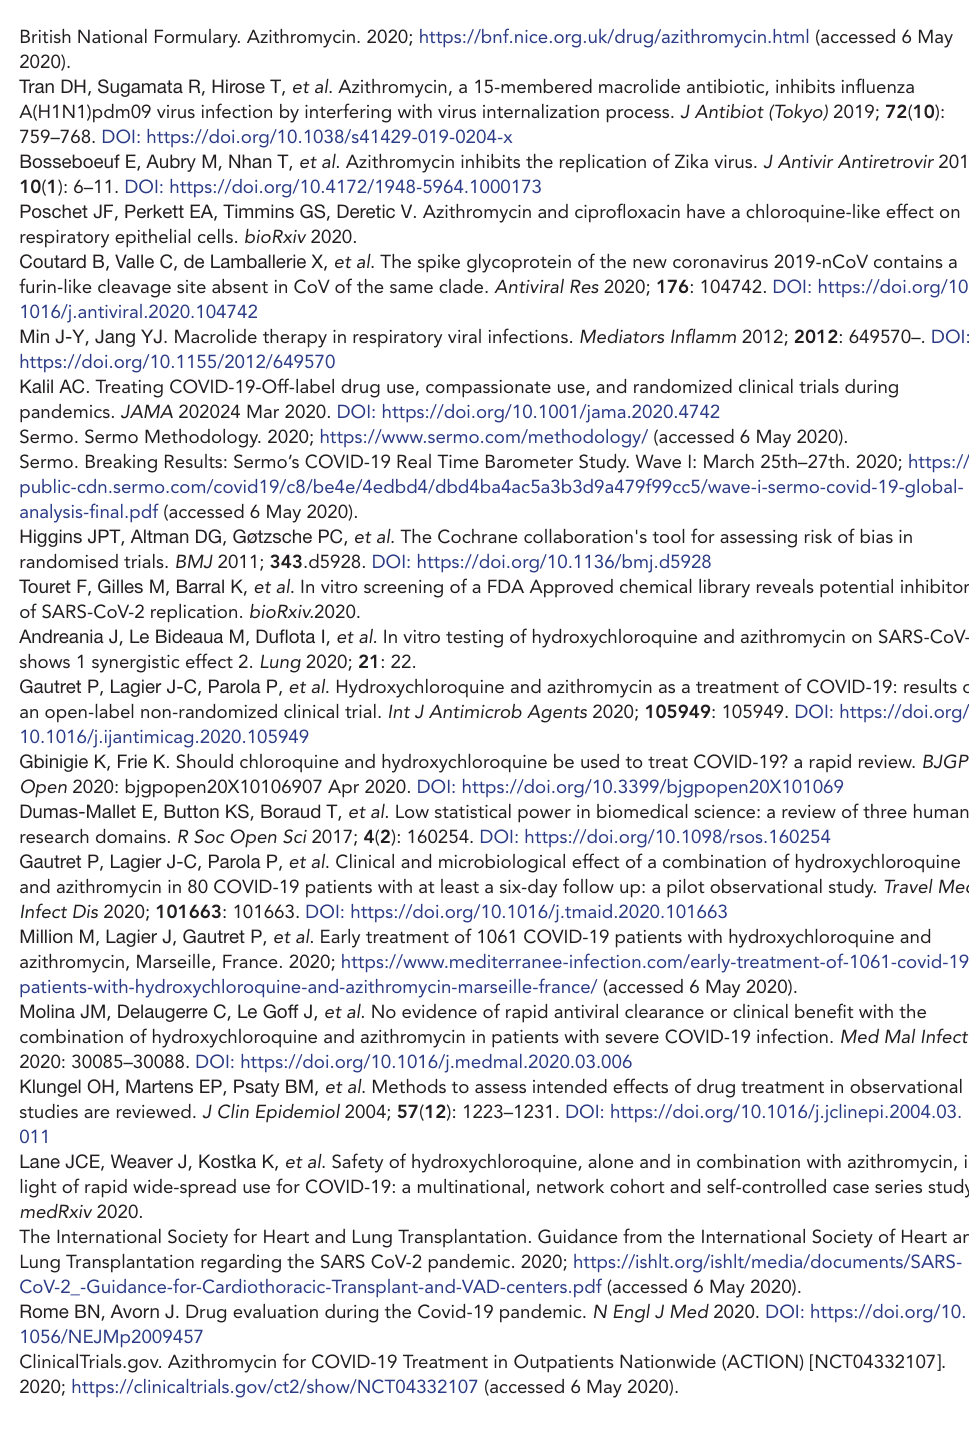
Gbinigie K and Frie K. BJGP Open 2020; DOI: